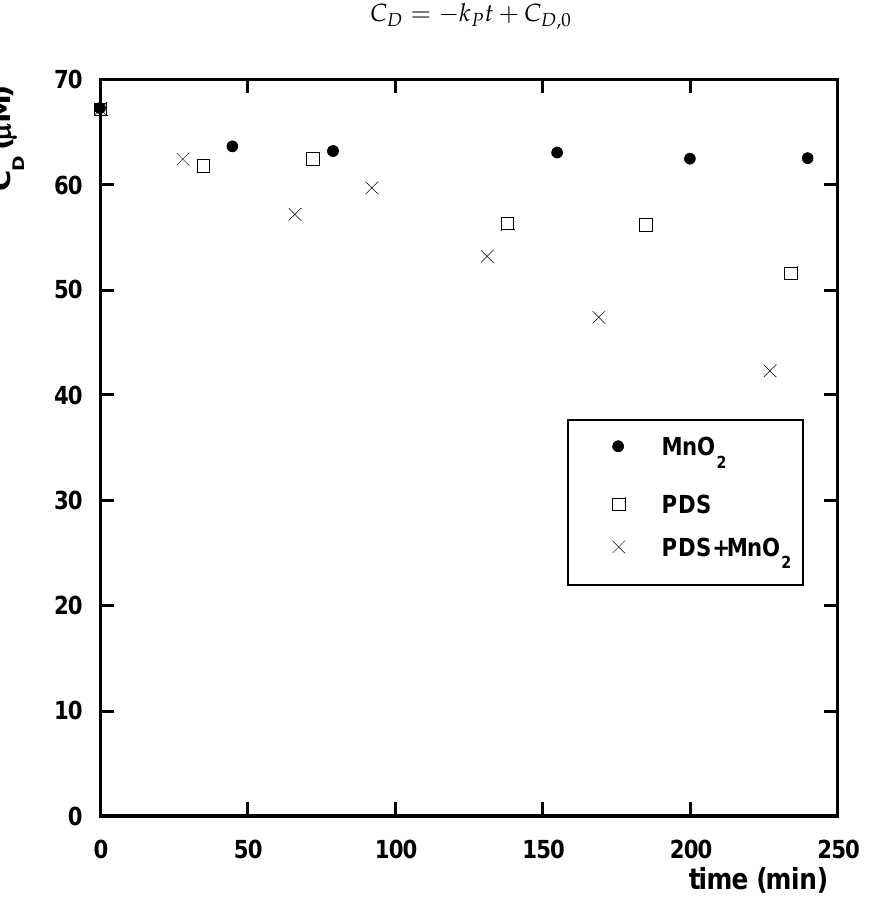
Figure 7. Diuron degradation kinetics profiles in the co-presence of MnO 2 (2.4 g L −1 ) and PDS (4.5 g L −1 ) at different temperatures; initial pH = 3.6.